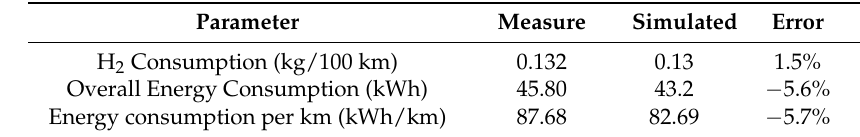
Table 9. Comparison of measure and simulated tests.